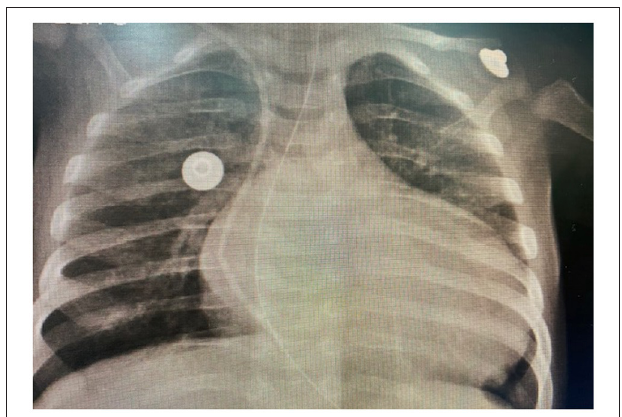
FIGURE 1 | Chest X-ray of the patient, taken on the February 12,